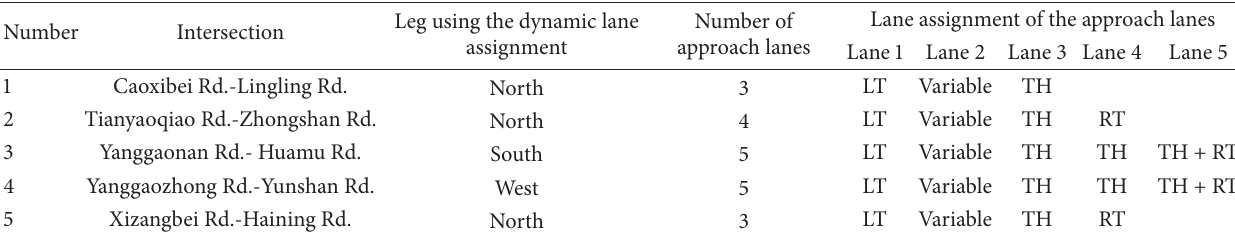
Table 1: Basic geometry information of the surveyed